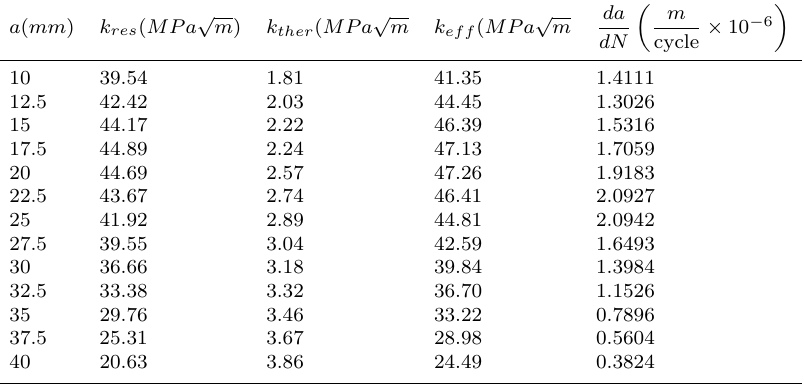
Table 7. Result of k eff and crack propagation rate